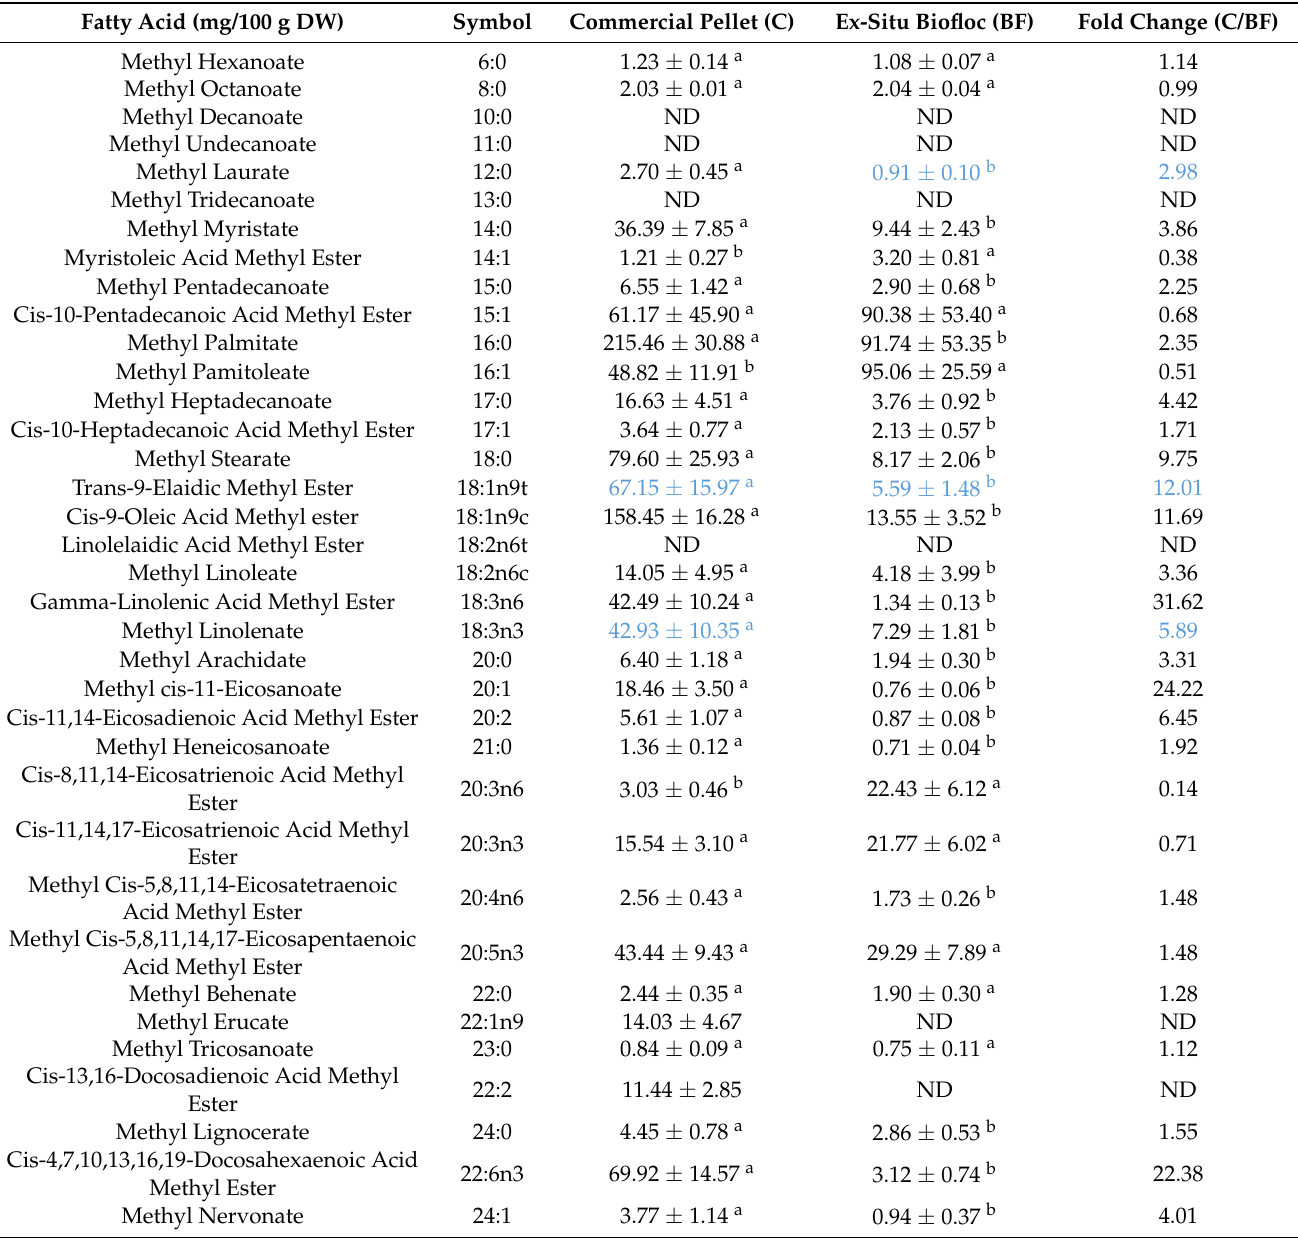
Table 6. Fatty acid profiles between commercial pellet and ex-situ biofloc. Different letters above the values indicate significant differences between the feeds. Letters a and b represent statistical analysis using student- t -test. Different letters comparing between commercial pellet and ex-situ biofloc represent significant difference ( p < 0.05). Fatty Acid (mg/100 g